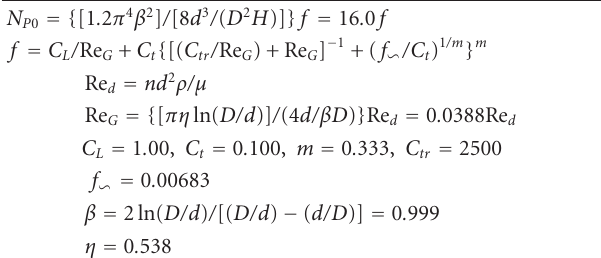
Table 4: Correlation equations of power number for helical ribbon